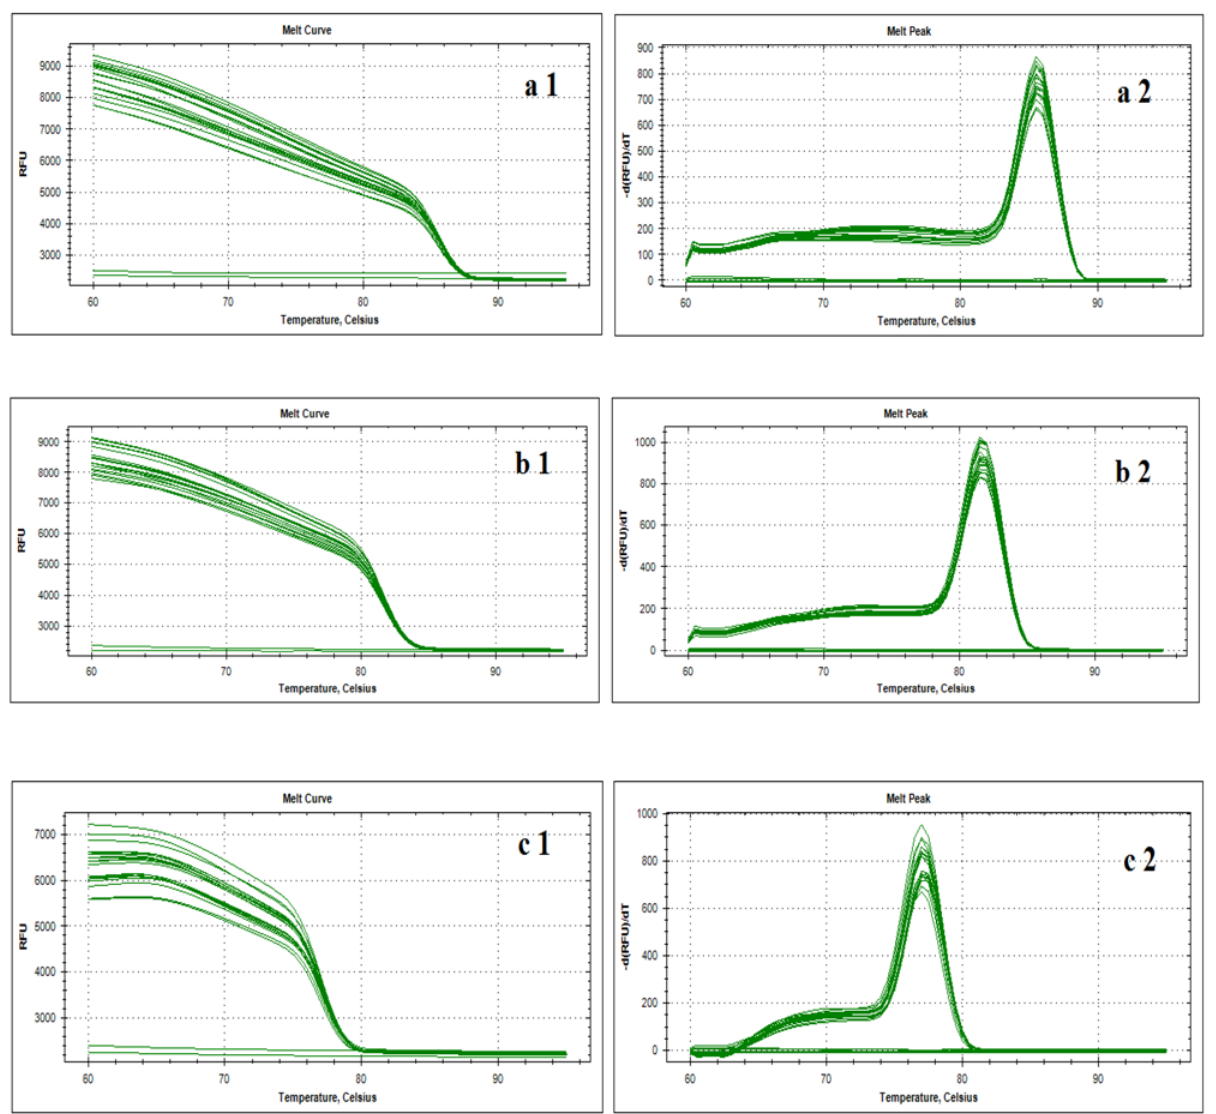
Fig 12. Different gene RT-PCR product melt curve analysis. a1and a2 represent the melt curve and peak of β -actin gene, respectively; b1 and b2 represent the melt curve and peak of Cyto C gene, respectively; c1 and c2 represent the melt curve and peak of caspase-3, respectively. For the genes β - actin, Cyto C and caspase-3 with corresponding melt temperatures of the specific target